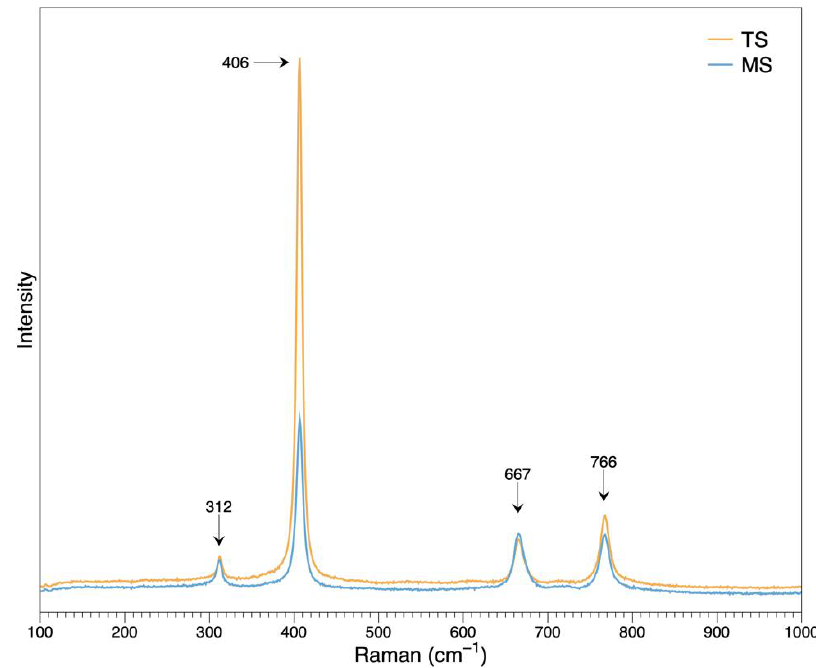
Figure 7. Raman spectra of spinels from Tanzania and Myanmar.